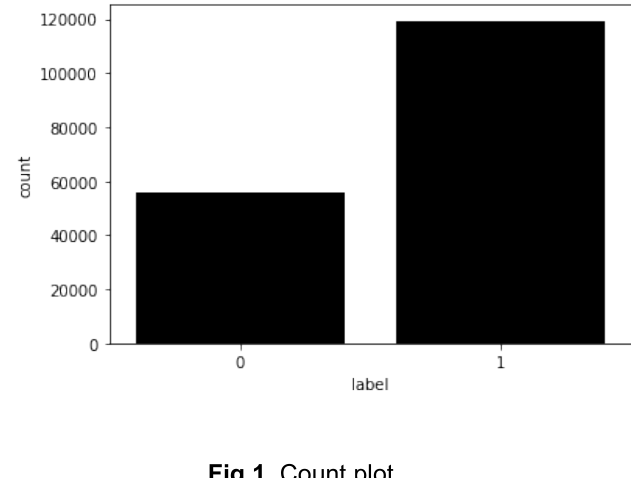
Fig 1. Count plot